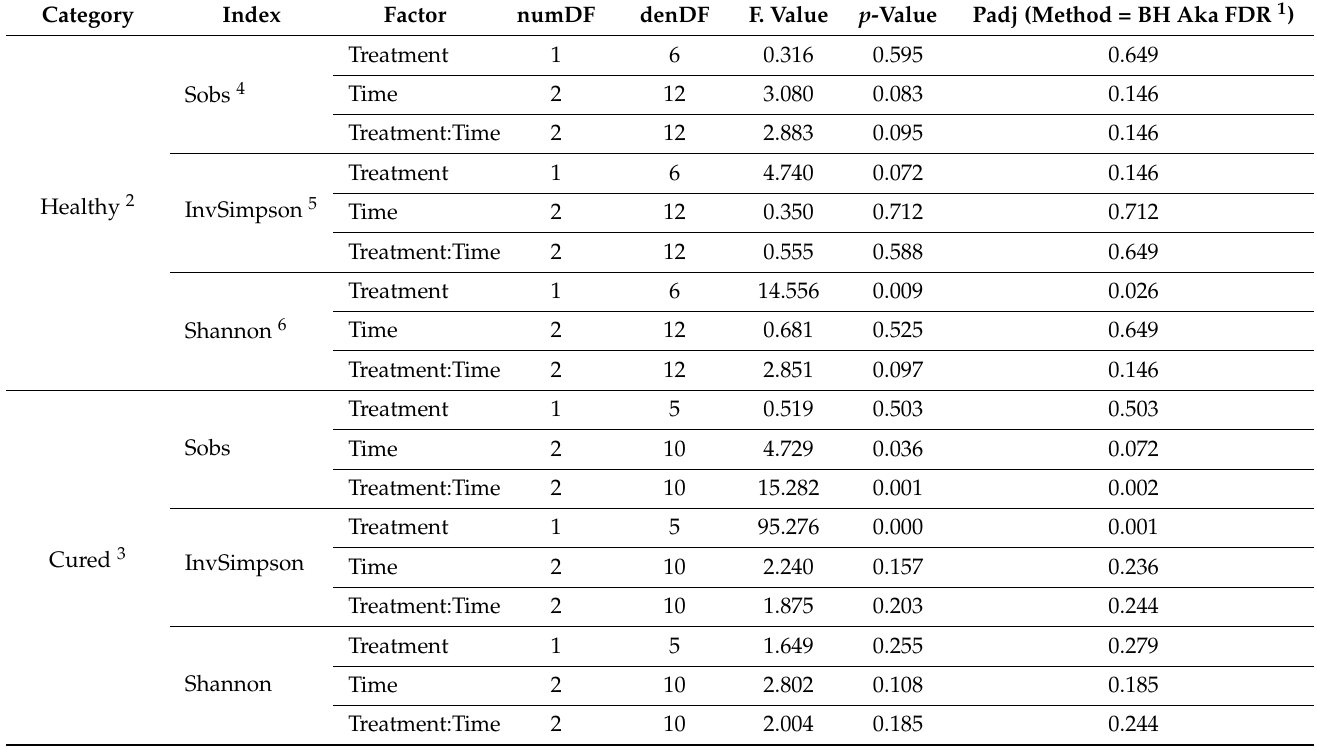
Table 3. Summary of analysis of variance of the bacterial alpha diversity of milk samples.